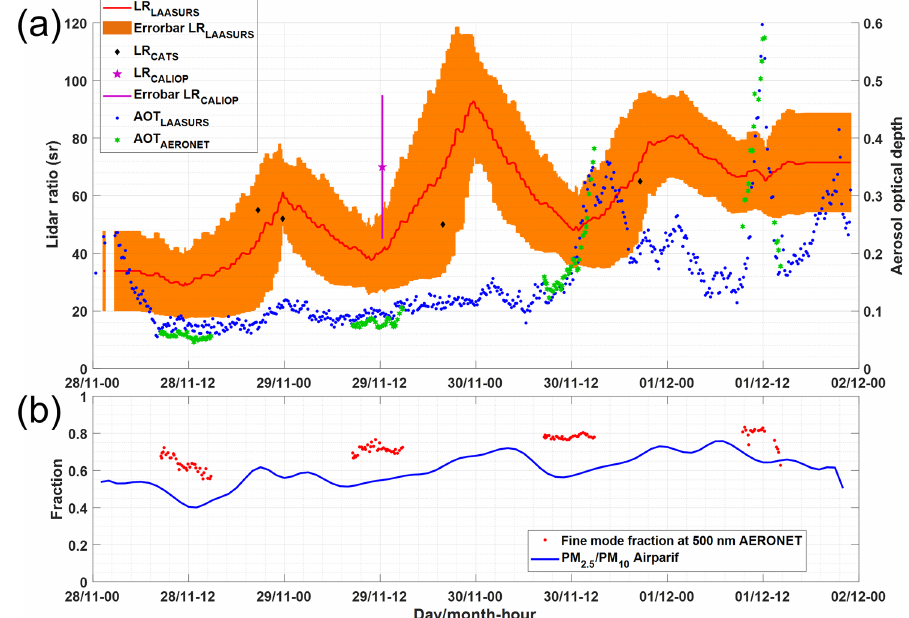
Figure 7. (a) Time series of lidar ratio (LR) and AOT at 355nm on November–December 2016. On the left y axis, the LR as retrieved from lidar measurements is presented in red. The orange area is the associated standard deviation. The LRs extracted from CATS and CALIOP operational products are represented as black diamonds and a purple star, respectively. On the right y axis, AOTs at 355nm retrieved from LAASURS and AERONET are represented in blue and green. (b) The temporal evolution of the fine-mode fraction operational product from AERONET is plotted along the PM 2 . 5 -to-PM 10 ratio from Airparif measurements.